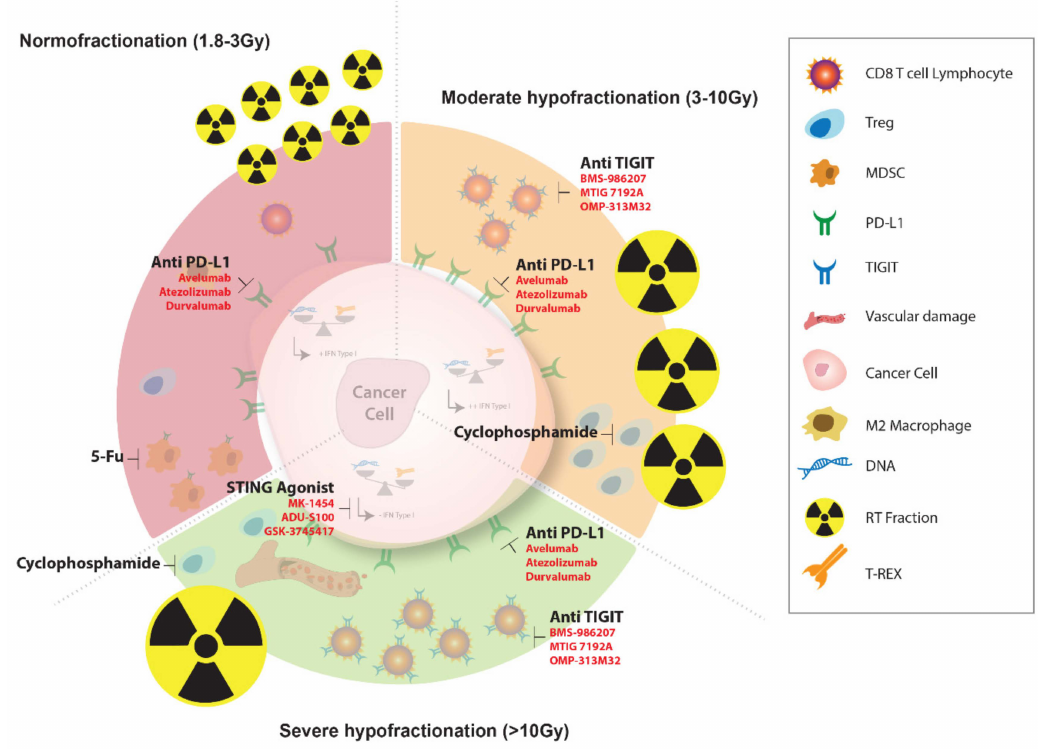
Figure 3. According to the immune response induced by three types of fractionation schedules, we suggest optimized radio-chemo-immunotherapy